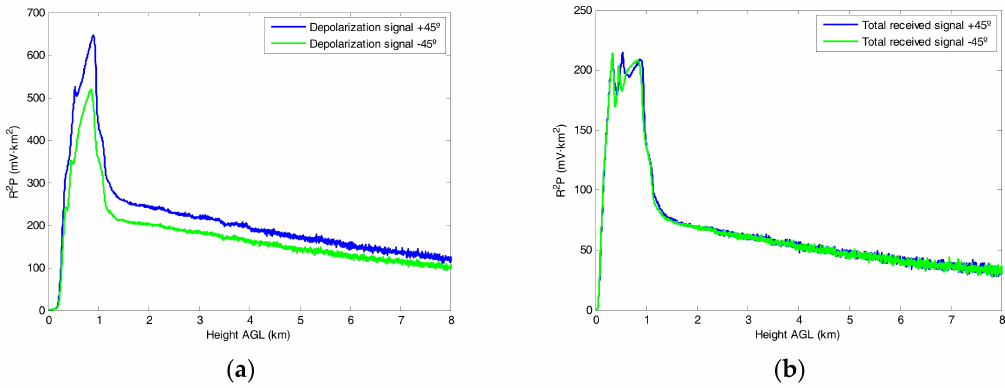
Figure 1. Depolarization signals ( a ) and total received signals ( b ) used in the calibration procedure.